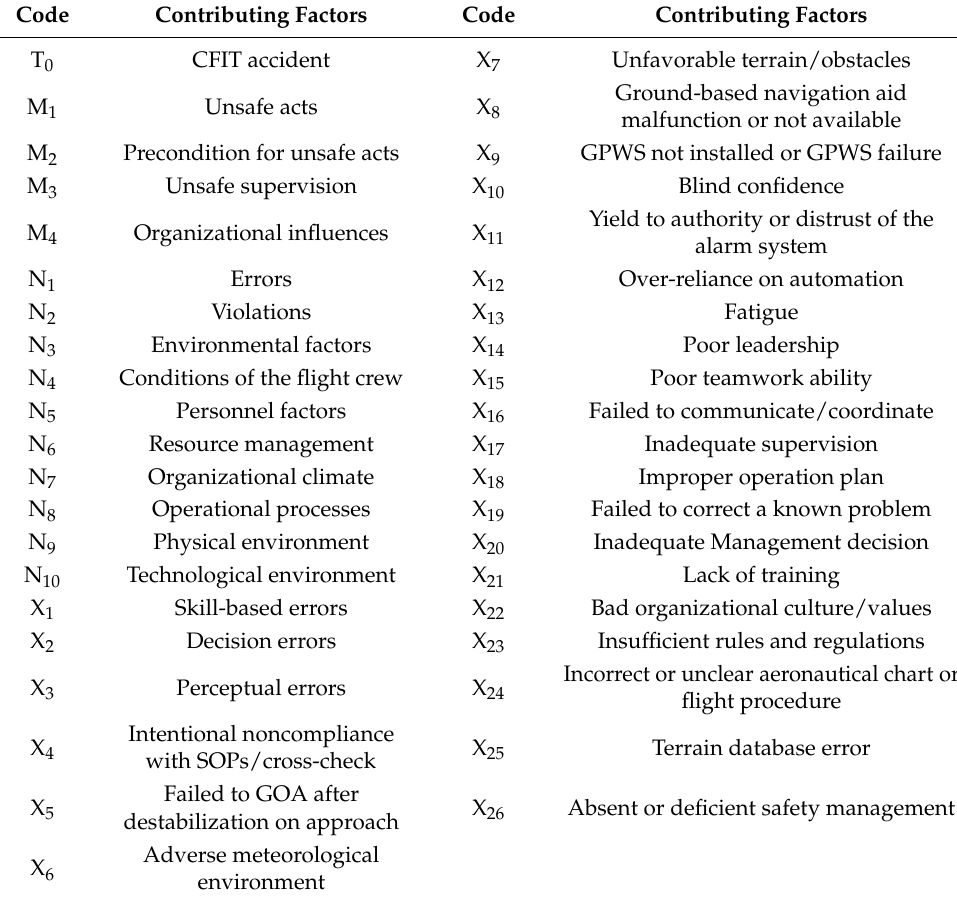
Table 2. The main contributing factors to CFIT